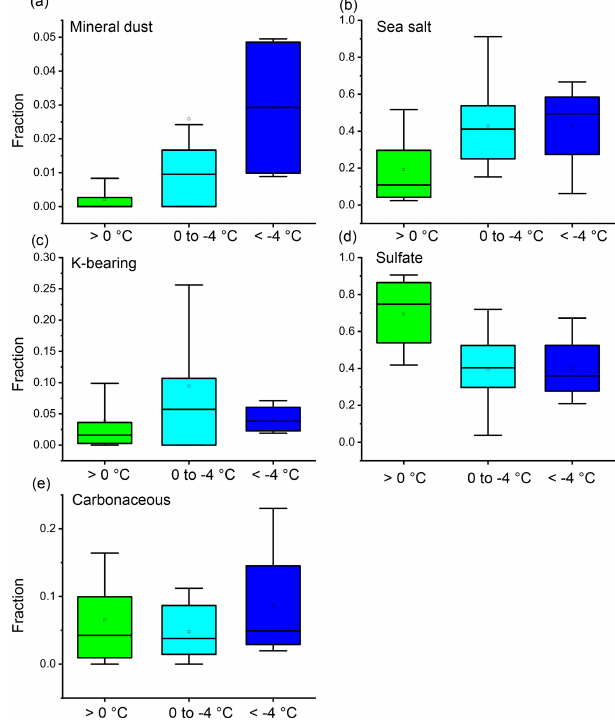
Figure 11. Number fractions of each aerosol type in cloud residual particle samples collected at > 0, 0 to − 4, and < − 4 ◦ C. (a) Mineral dust particles, (b) sea salt particles, (c) K-bearing particles, (d) sul- fate particles, and (e) carbonaceous particles. Sample numbers are 20, 25, and 4 for those collected at > 0, 0 to − 4, and < − 4 ◦ C, respectively. Wide boxes, whiskers, and squares indicate the 25th, 50th, and 75th percentile ranges; 10th–90th percentile ranges; and average values,